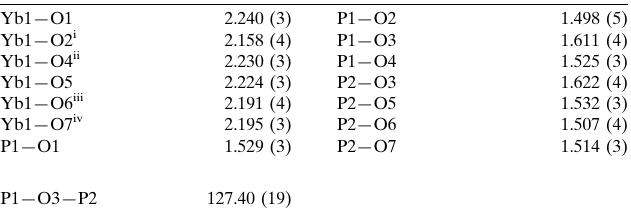
Selected geometric parameters (A˚ , (cid:3) ).